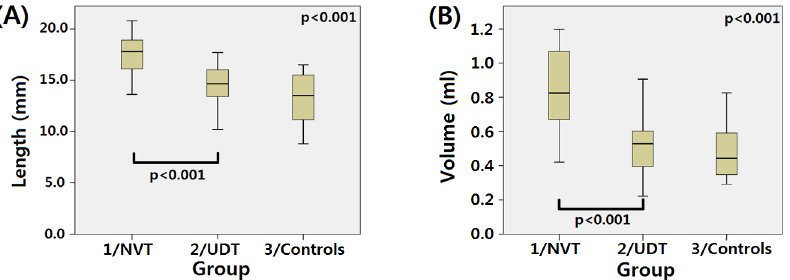
Fig 1. Median testicular length (A) and volume (B) were compared and showed significant differences among the groups. Post hoc evaluation using the Mann-Whitney U test revealed that group 1 (NVT) had a significantly longer length and larger volume than group 2